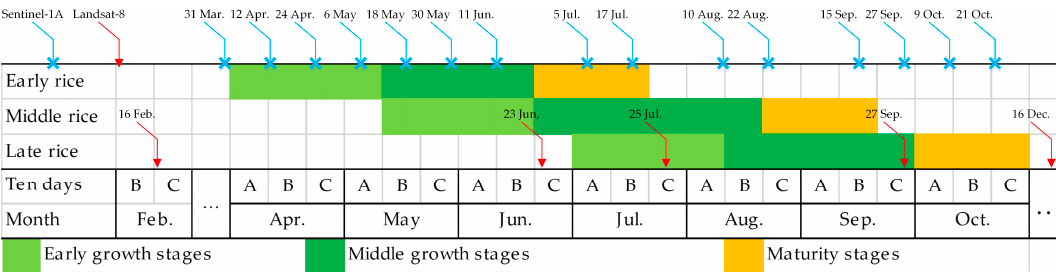
Figure 2. S1A and Landsat image acquisition dates and rice crop calendar in Poyang Lake Plain from early April to late October, showing the early, middle and late stages. The blue sign represents S1A image acquisition dates. The red sign represents Landsat-8 image acquisition dates. The letter “A” represents the first one-third of a month, letter “B” represents the middle third, and letter “C” represents the last third. The early growth stage mainly comprises the sowing and transplanting periods.